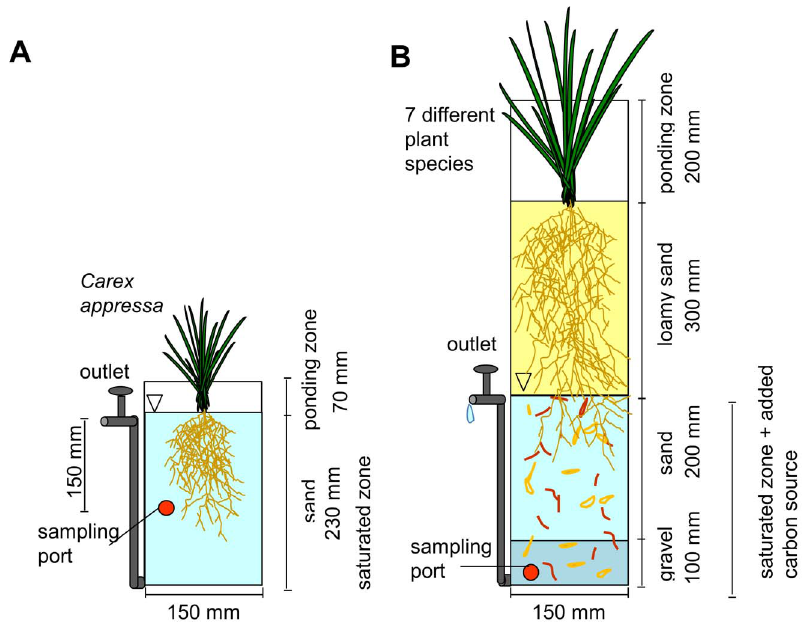
Figure 1. Experiment Configuration. A.) Influent concentration experiment (under fully saturated conditions) and B.) Multiple plant species experiment (with saturated zone overlaid by a non-saturated zone). Note diagrams are not drawn to scale.